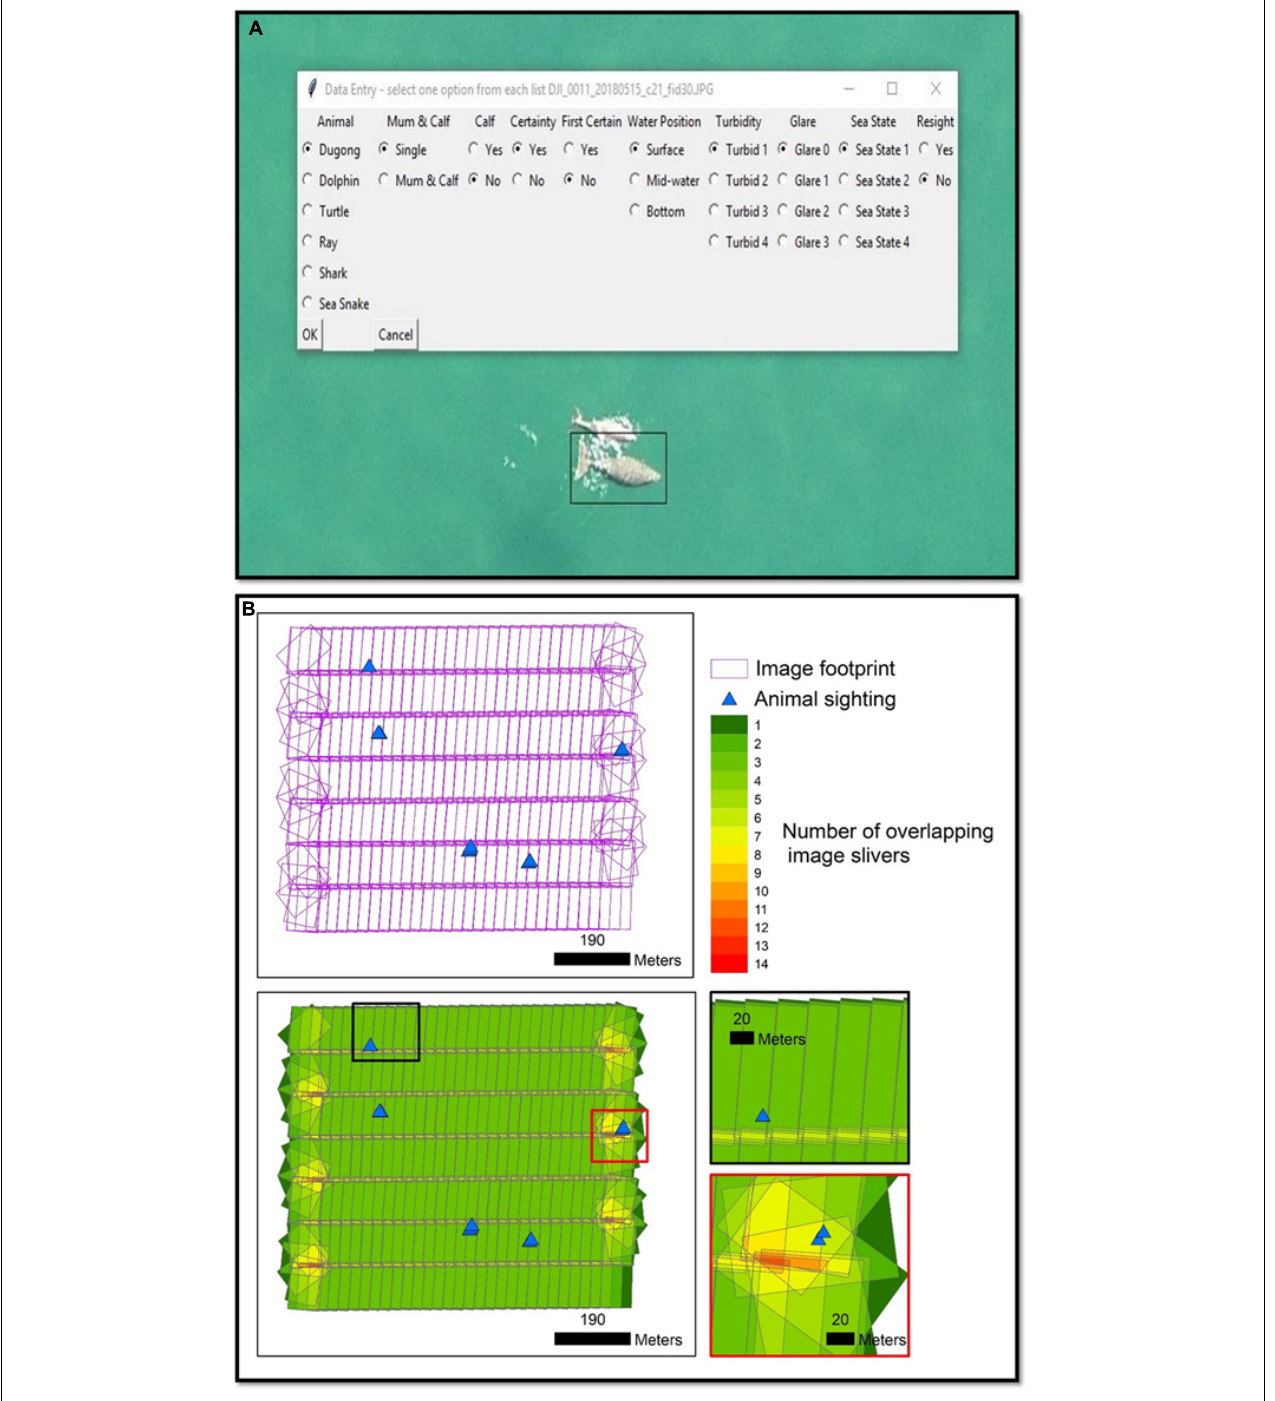
FIGURE 3 | Manual image review (A) and mapping (B) process. The term “animal sighting” here refers to a single individual sighting (e.g., a single dugong, or a mum or calf in a mum-calf group).